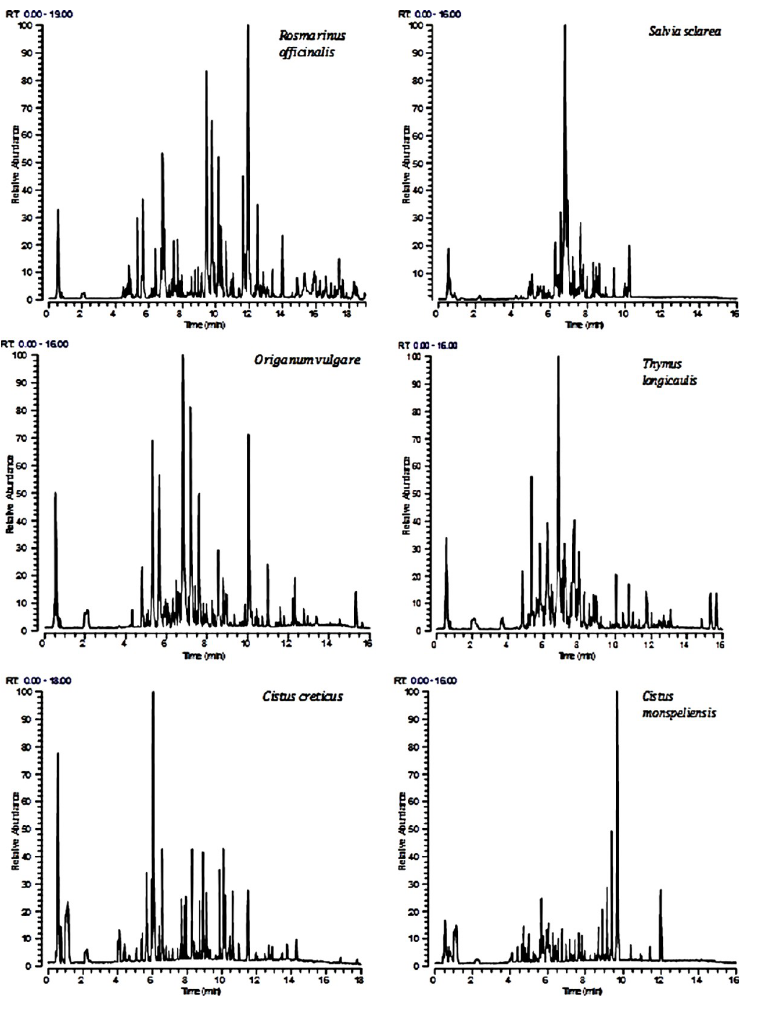
Fig 3. LC(ESI-)HRMS chromatograms of the methanol extracts of the tested